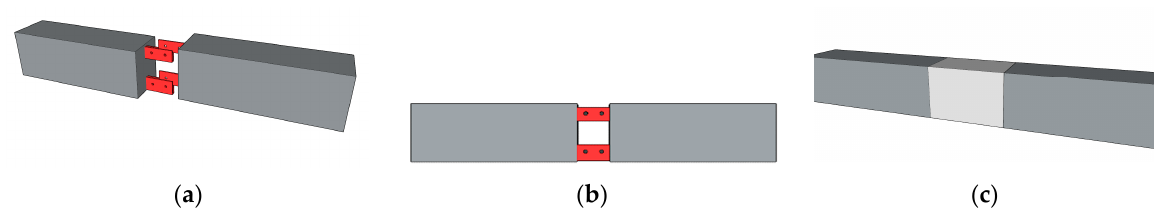
Figure 3. Construction process of the proposed precast concrete modular beam system: ( a ) connection between U-shaped and I-shaped steel plates; ( b ) bolted connection between plates; ( c ) injection of non-shrink mortar.